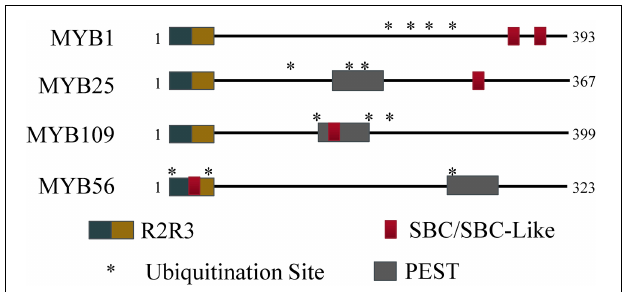
FIGURE 1 | Protein regions for MYB56 and the S23 subfamily. All S23 members have an R2R3 domain at the N-terminus. Predicted SBC and PEST regions are present to varying degrees among the S23 subfamily, however all three members contain at least three predicted ubiquitination residues (indicated by *) and at least one SBC or PEST